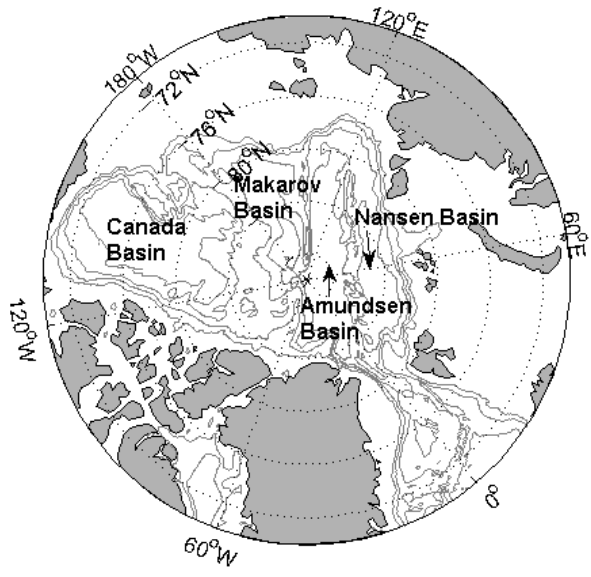
Figure 2. The basins of the Arctic